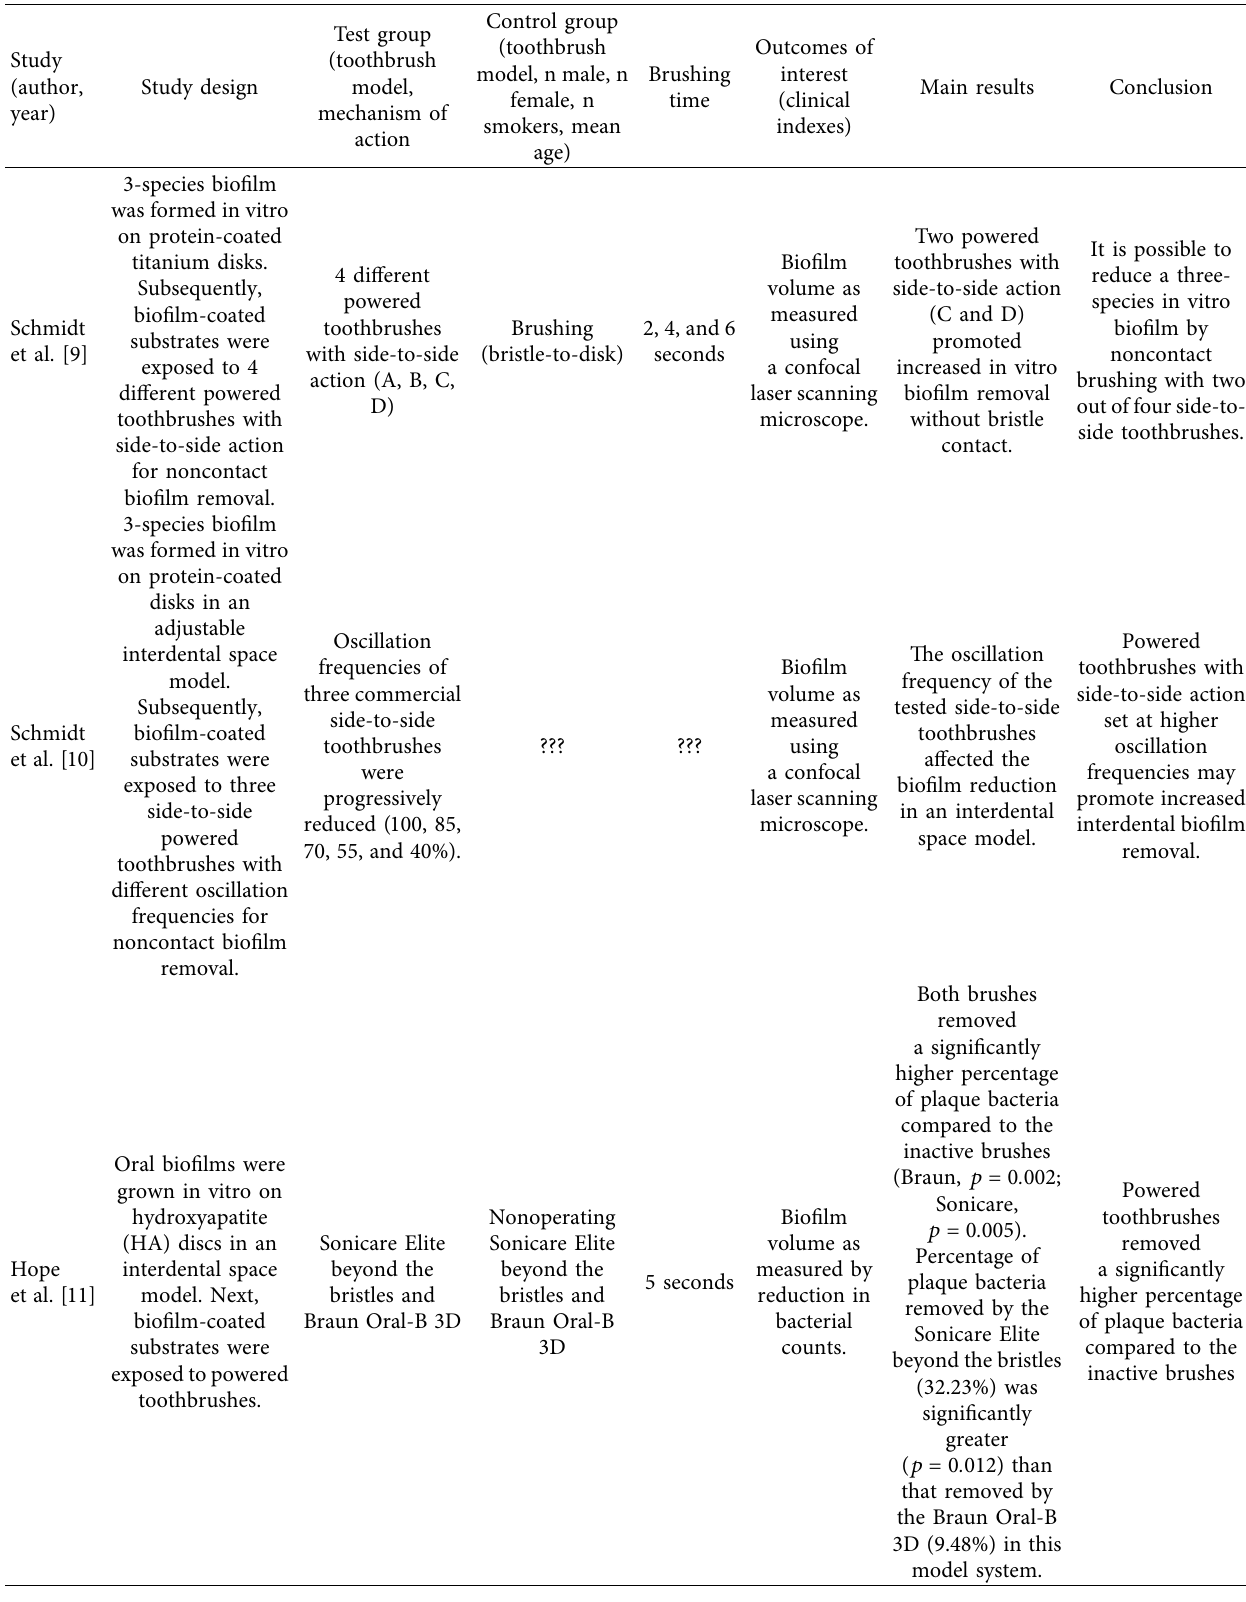
Table 1: Studies that compared the effectiveness of manual and powered toothbrushes on microbial